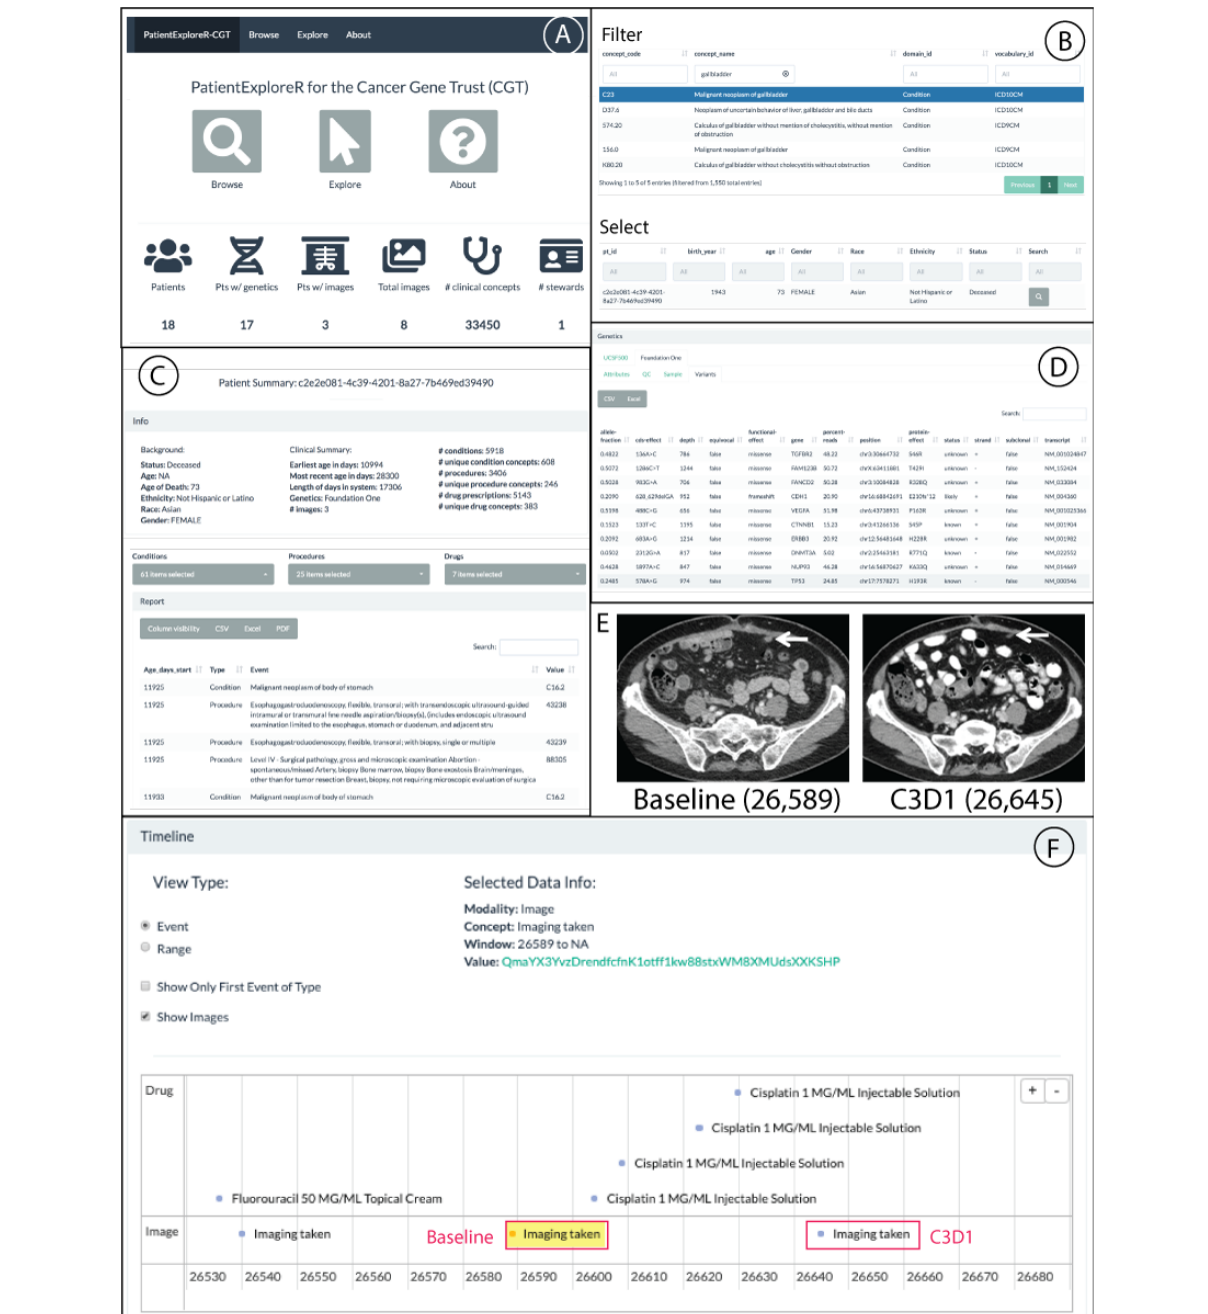
Figure 3. PatientExploreR visualization app for Cancer Gene Trust (CGT). Breakdown of features available for the public PatientExploreR visualization application for CGT. (A) Landing page which has all options for browsing patients, exploring patient data, and information about CGT. This page also displays the amount of data currently compiled on CGT. (B) Browse tab for filtering for patient based on clinical concepts and/or demographics. This list is filtered by Gallbladder-related disease and patient c2e2e081-4c39-4201-8a27-7b469ed39490 was selected. (C) Explore tab that details patient’s background and clinical summary. The user can interact with clinical, genomic, and imaging data for selected patient. These data can be filtered and exported and control what is shown visually in the timeline view below. (D) Genomics data extracted and displayed from either the Foundation One or UCSF 500 report. (E) Two sample image scans that can be found via the imaging submenu or from clicking within the timeline view below. These CT scans show baseline and C3D1, 26,589 and 26,645 age in days, respectively. Baseline contrast enhanced CT of the abdomen shows a peritoneal metastasis (arrow) measuring 12×8 mm. Posttreatment contrast enhanced CT of the abdomen shows decreased size of the peritoneal metastasis (arrow) measuring 10×6 mm. (F) Timeline view of selected clinical and image data. This timeline view was produced by selecting the associated relevant medications in the Drug pull-down menu, specifically: capecitabine, cisplatin, fluorouracil, and trastuzumab. With Show Images selected, we can see what relevant medications the patient was prescribed when the images were taken. Pressing the link next to Value above, the user will be directed to all images taken during that visit, which can be viewed on an appropriate (eg, DICOM viewer)